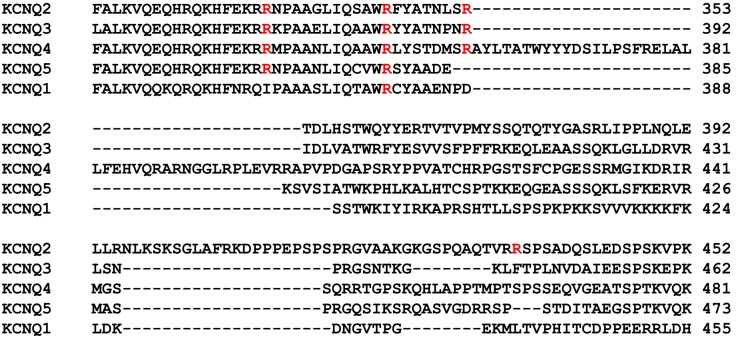
The sequence alignment of 5 difference human KCNQ isoforms.The arginine residues critical for methylation in KCNQ2 are marked in red. KCNQ3 and KCNQ4 have 3 conserved arginine residues while KCNQ5 and KCNQ1 have two or one conserved arginine residues, respectively. Note that KCNQ2 and KCNQ3 form M currents in brain.